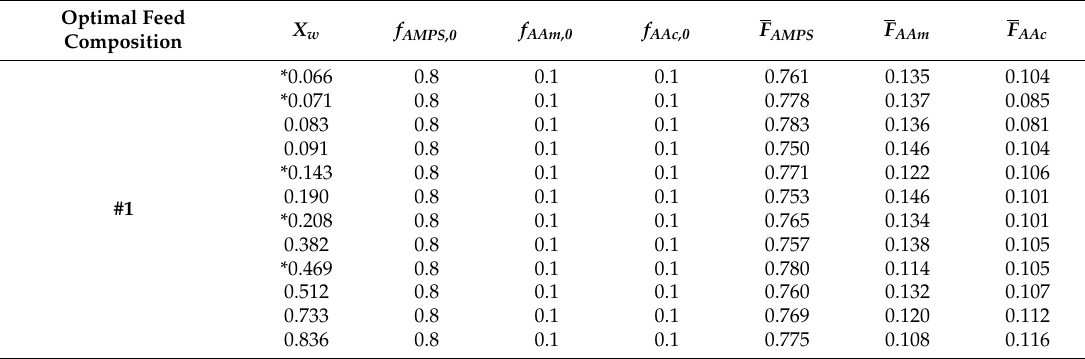
Table 3. Experimental data for AMPS/AAm/AAc terpolymerization; medium-high conversion. Optimal Feed X Composition